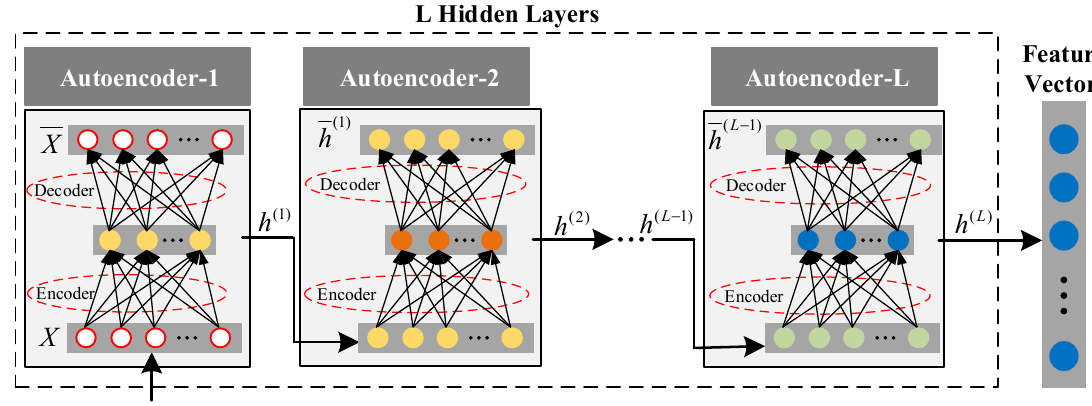
Figure 2. DAE structure with L hidden layers.